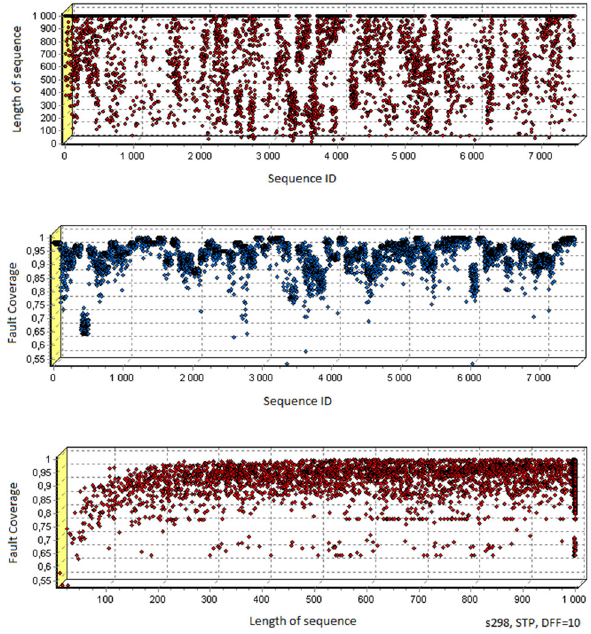
Fig. 29 STP for s298 with use of 8 internal flip-flops